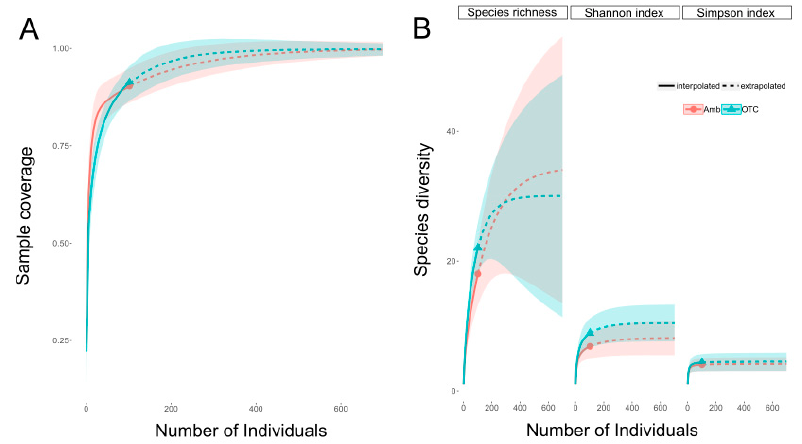
Figure 2. Sample coverage of the expected ( A ) bee species richness and ( B ) diversity rarefaction for the collected bee specimens in ambient (red) and warmed (OTC, blue) treatments. The shaded regions indicate 95% confidence intervals.